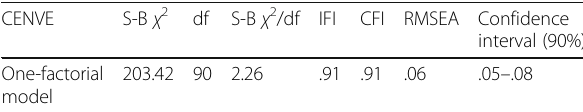
Table 1 Goodness of fit indices for different ML models of CENVE CENVE